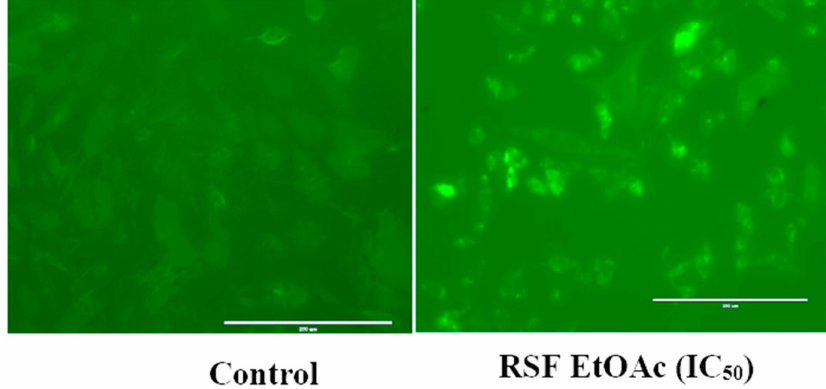
Figure 4. Activation of caspase-3 and 7 in MDA-MB-231 cells. Cells were treated with vehicle and at IC 50 for 24 h. Activated caspase-3/7 was visualized by fluorescence microscopy. (RSF EtOAc) R. stricta fruit ethyl acetate extract was used.